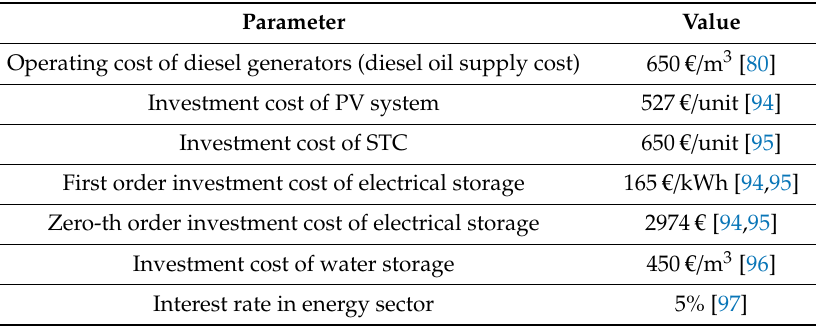
Table A4. Economic